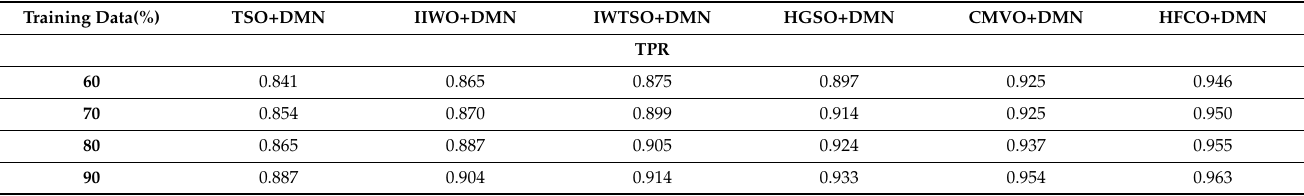
Table 9. Analysis based on optimization using 20Newsgroup dataset for TPR, TNR, FNR, precision, and testing